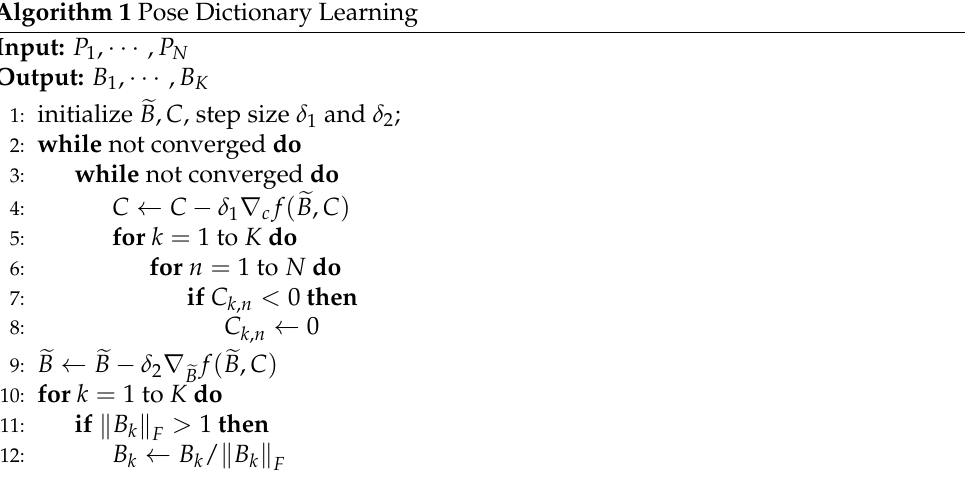
Algorithm 1 Pose Dictionary